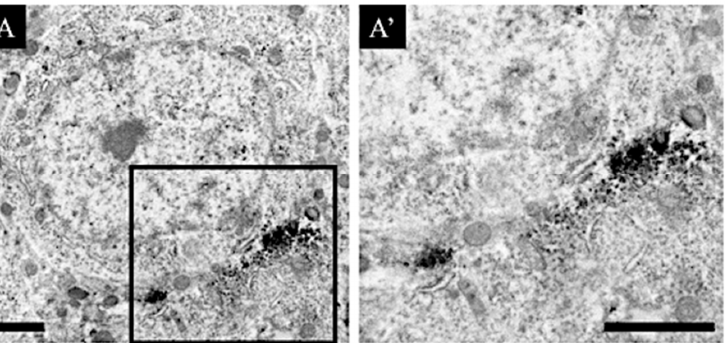
Figure 7. M1 muscarinic acetylcholine receptor-staining sections are shown: ( A ) shows the lower magnification view and ( A’ ) shows the higher magnification view. ( A , A’ ) indicate the DAB-reacted M1 muscarinic acetylcholine receptors of CA1 neurons of the aniracetam and α -GPC-treated animals. Scale bars in both ( A , A’ ) = 2 μ m. 3.5. Changes in the Expression of Acetylcholinesterase and Choline Acetyltransferase after Smart Drug Administration